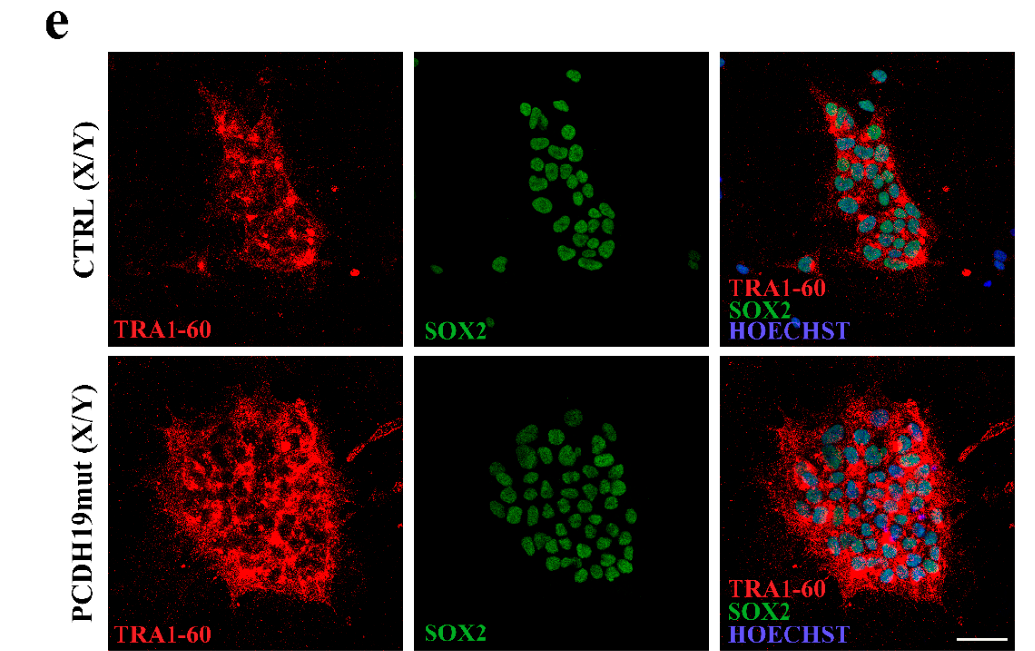
Figure 1. Characterization of iPSCs obtained from fibroblasts of a mosaic male patient (PCDH19mut (X/Y)). ( a ) Brightfield images of CTRL and patient-derived iPSCs; ( b ) ALP staining of PCDH19mut iPSCs compared to CTRL iPSCs; ( c ) Analyses of genome stability of the generated PCDH19mut iPSCs (red bar graph) and CTRL iPSCs (blue bar graph); ( d , e ) Immunofluorescence assays in CTRL and PCDH19mut iPSCs for pluripotency markers OCT4 ( d ), SSEA4 ( d ), SOX2 ( e ) and TRA1-60 ( e ). Scale bar = 50 μ m.